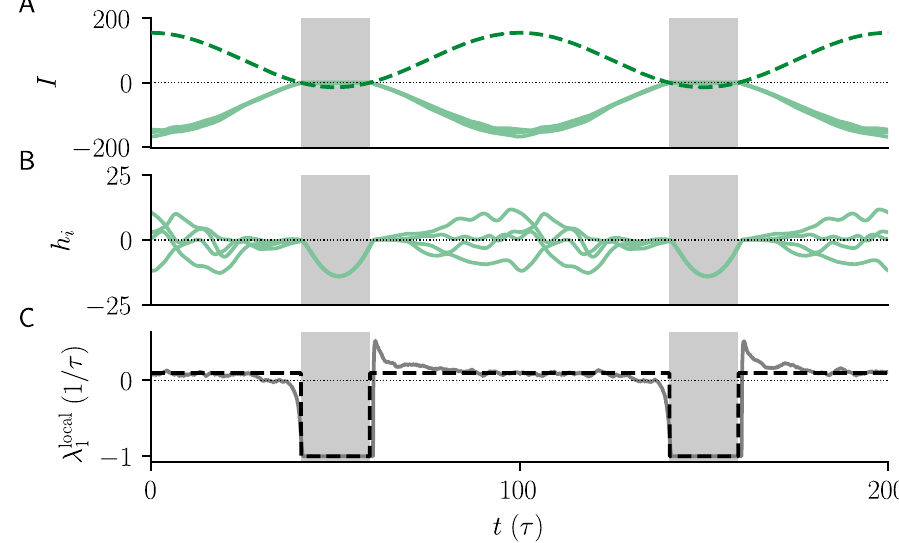
Fig 4. Mechanism of chaos suppression with slowly varying common input. A) External input ffiffiffiffi p ð t Þ ¼ ð t Þ (dashed) and recurrent input I rec I in N I 0 þ d I i i Synaptic currents h i for four example neurons. C) Local Lyapunov exponent from network simulation, which reflects the local exponential growth rates between nearby trajectories (solid), and Lyapunov exponent from stationary DMFT (dashed) used in quasi-static approximation. When I silences the recurrent activity (gray bars). During these silent episodes, the network is no longer chaotic and l local ¼ (cid:0) 1 = t . When the input is positive, dynamics remains chaotic and l local 1 N = 5000, g = 2, f = 0.01/ τ , I 0 = J 0 =